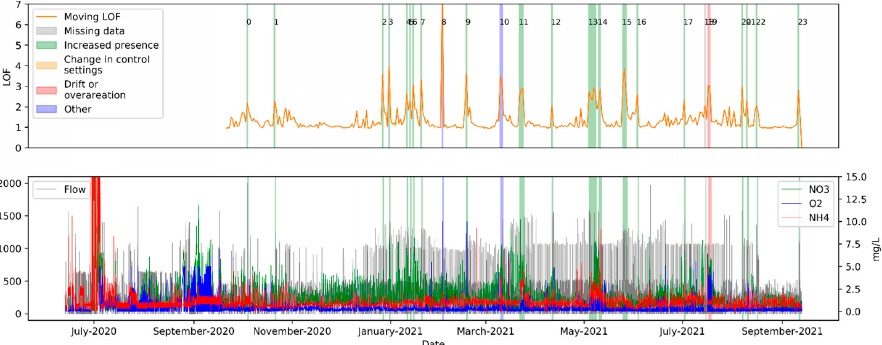
Figure 6. WWTP2 PCT2. In the upper graph the orange line shows the Moving LOF and the coloured areas, numbered from 0 to 23, show anomalies detected when the Moving LOF exceeded the threshold of two. The lower graph shows the flow, NO 3 , DO and NH 4 . No calibration data were available from the